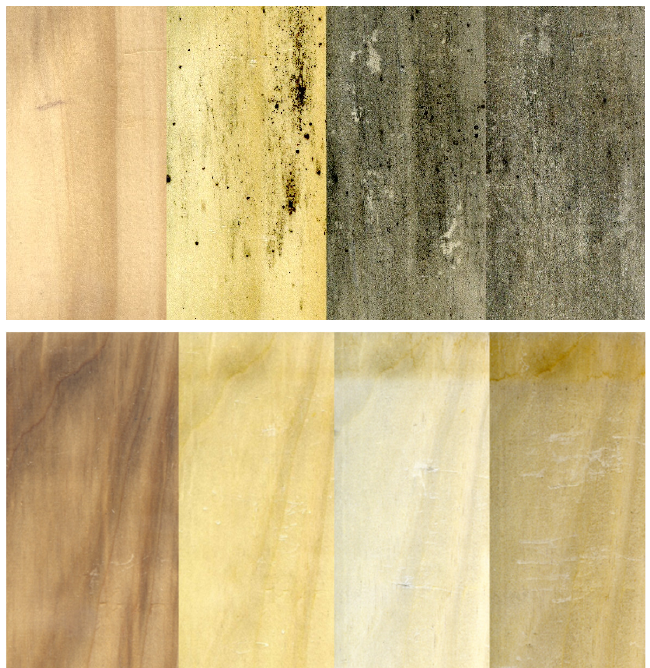
Figure 12. Examples of the same acetylated wood specimen treated with HN and exposed outdoors on a test fence near Corvallis, OR, for 0, 6, 12, and 18 months ( top row ) and a similarly treated sample exposed at Madras, OR, for 0, 6, 15, and 25 months ( bottom row ).